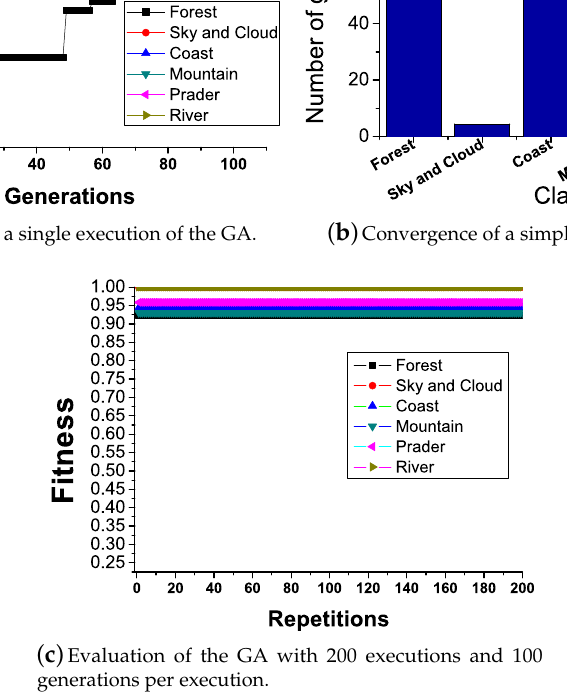
Figure 19. Performance of the GA for the natural scenery contained in the